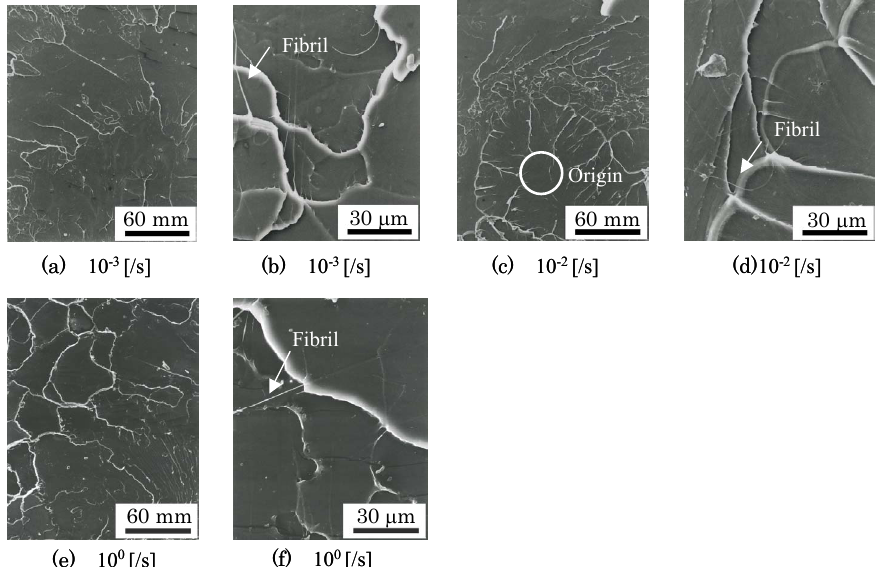
Figure 4 Fracture surface of non-annealing specimens observed by scanning electron microscopy.